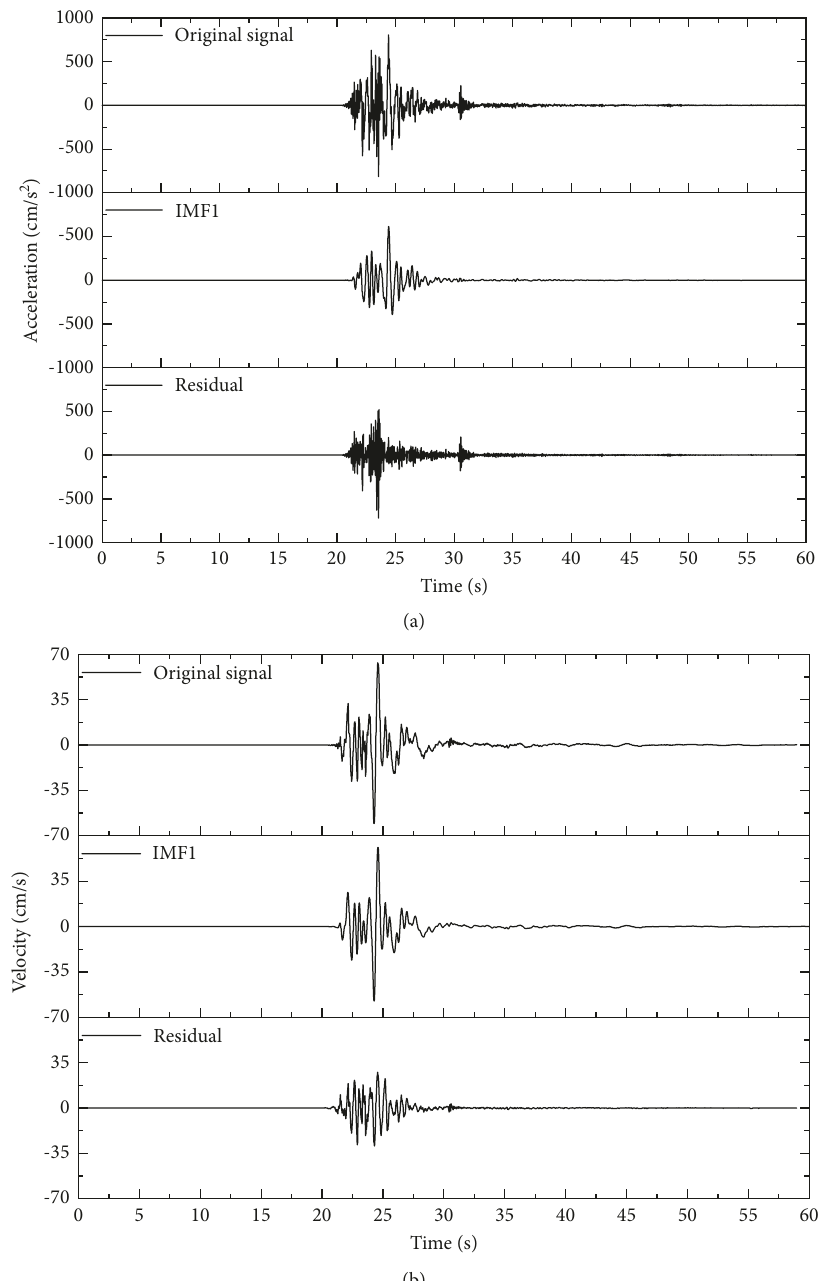
Figure 19: Acceleration and velocity time history of 53LLT (EW). (a) Acceleration time history. (b) Velocity time